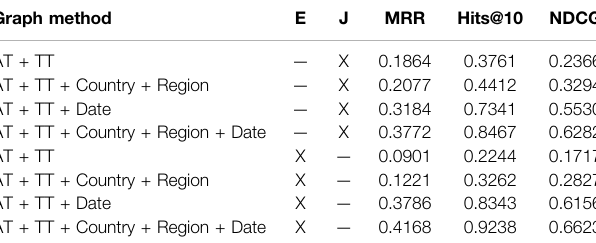
TABLE 5 | Results of hybrid methods on the event link prediction task. E and J respectively indicate whether the method is an “ ensemble ” or “ joint ” method. Graph method